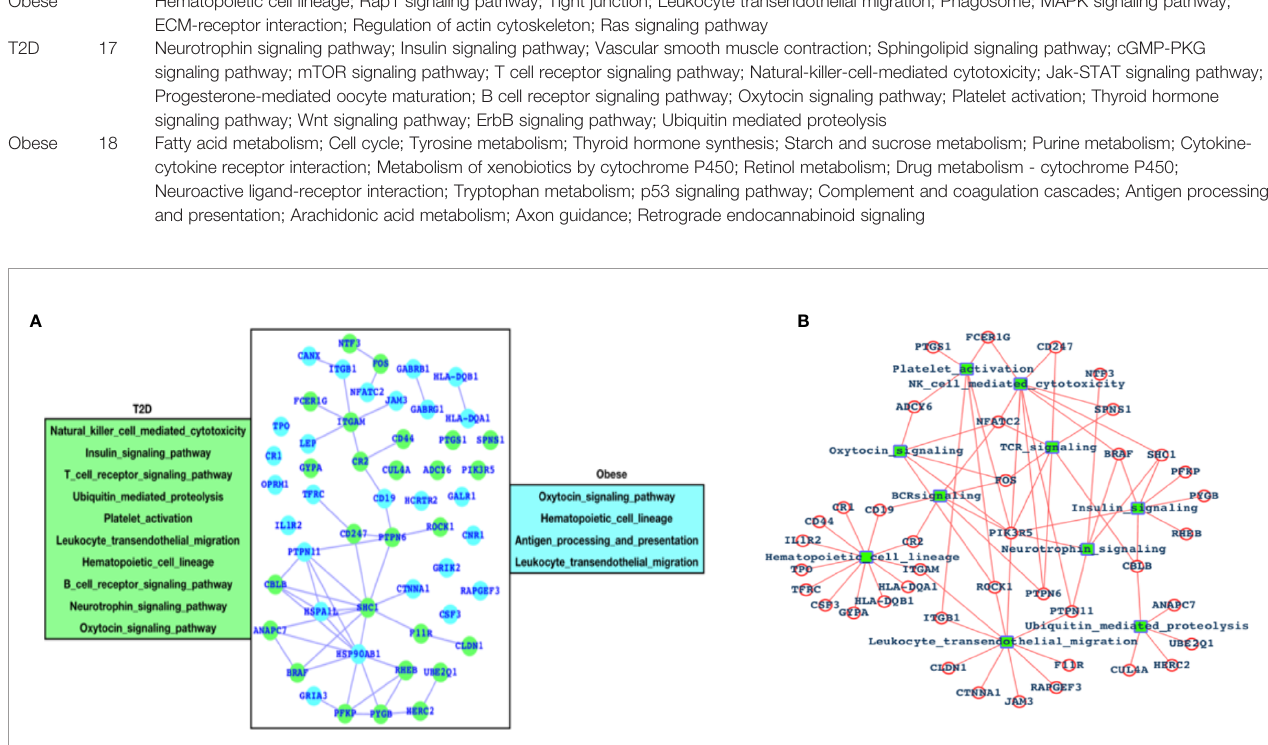
FIGURE 2 | Genes associated with immune systems. (A) Green-colored genes belong to the immune system when the patient is suffering from T2D and cyan- colored genes belong to the immune system in case of obesity and (B) network of immune signaling pathways and their components